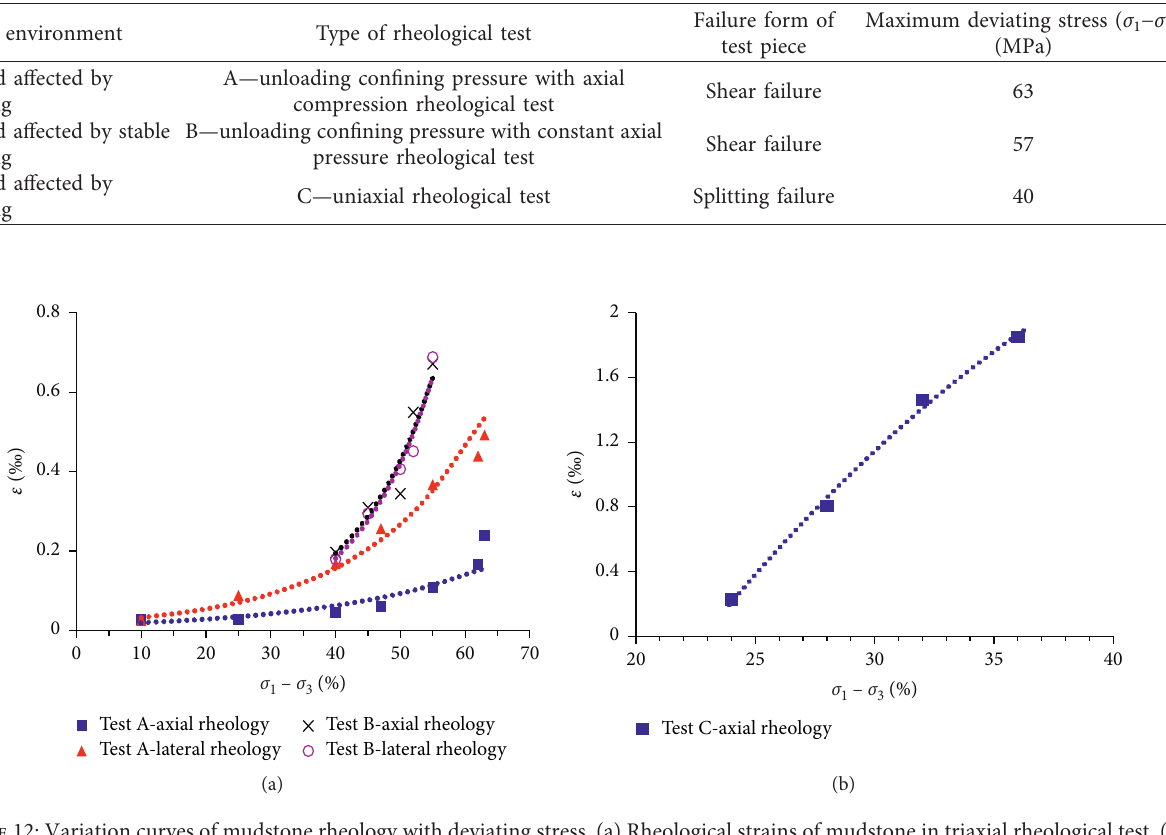
Table 7: Failure modes of mudstone rheological test specimen.